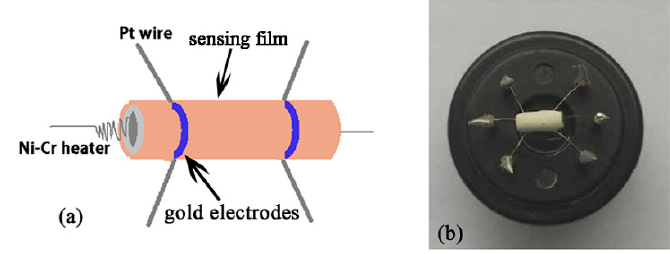
Figure 1. ( a ) The schematic diagram of a typical gas sensor; ( b ) the photo of the prepared sensor.